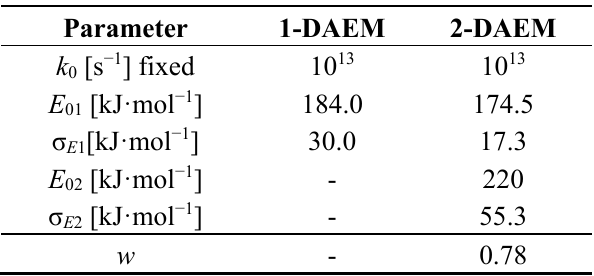
Table 3. Kinetic parameters obtained with the 1-DAEM and 2-DAEM at 20 K·min −1 for the